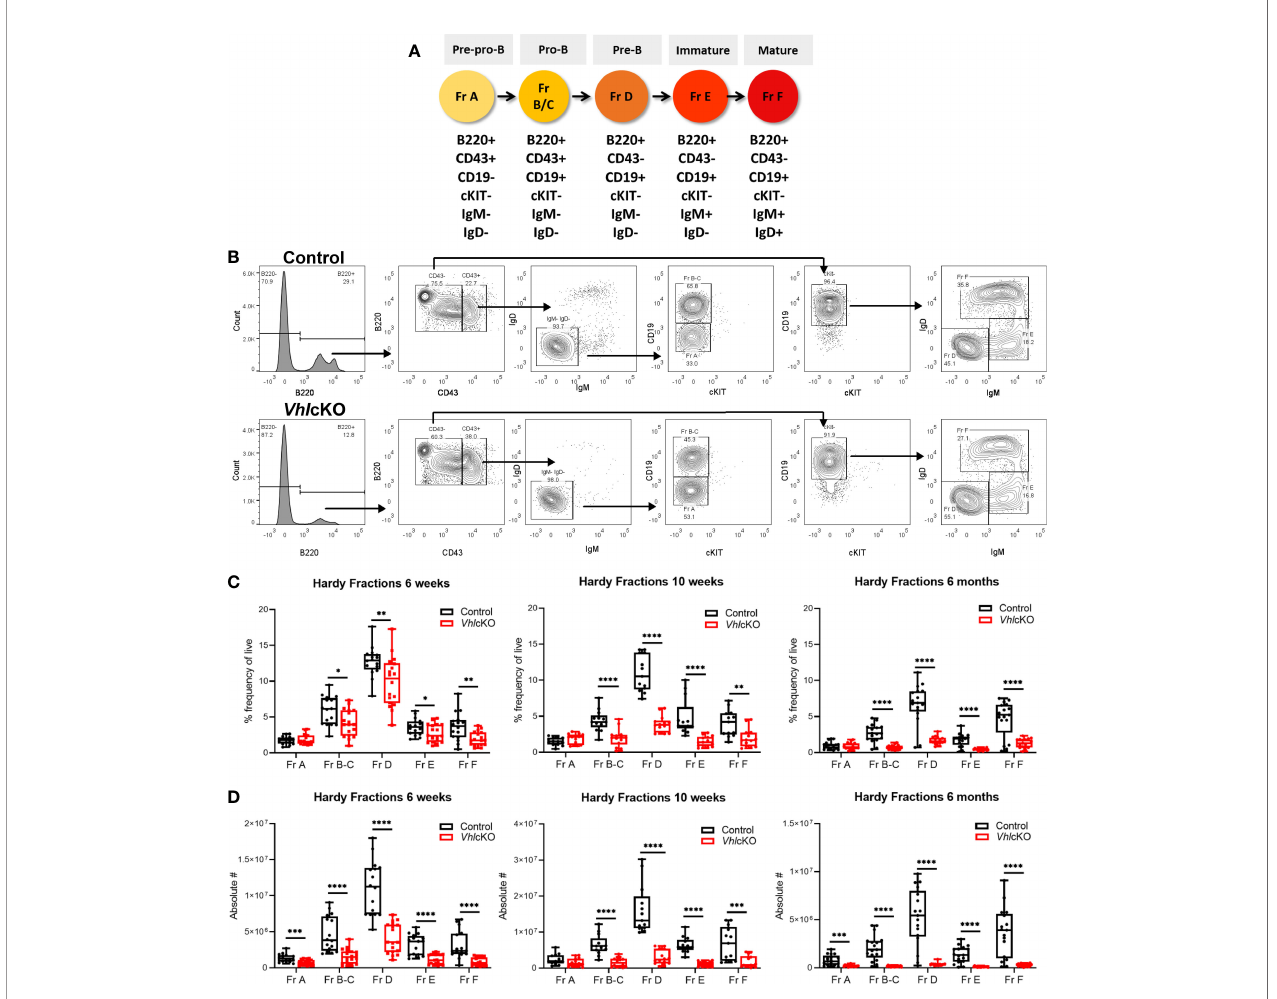
FIGURE 3 | Dysregulated B cell development in Vhl cKO mice bone marrow. (A) Antigen markers used to identify and distinguish B cell development stages by fl ow cytometry. (B) Representative FACS plot of B cell development in the BM control (top) and Vhl cKO (bottom); (C) B cell frequency in 6-week-old (left), 10-week-old (middle), and 6-month-old (right) mice; (D) absolute cell numbers in 6-week-old (left), 10-week-old (middle), and 6-month-old (right). p<0.05*, p<0.01**, p<0.001***, p<0.0001**** two-tailed Student ’ s